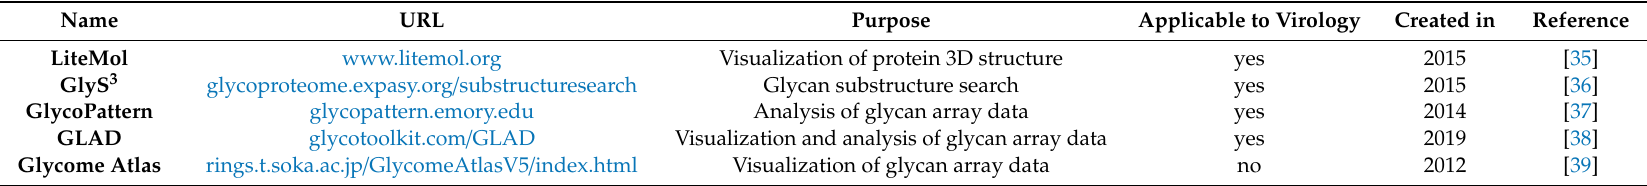
Table 2. The tools either used in the example of Figure 3 or mentioned in the text as known to visualize or analyze glycan-binding data are briefly described and qualified for their relevance to